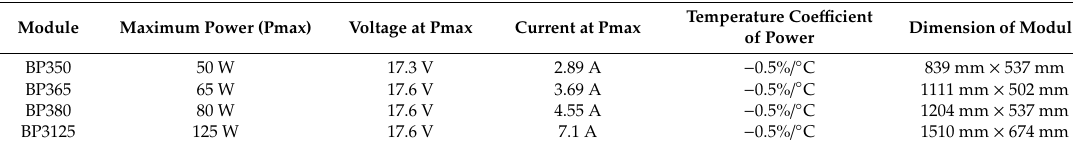
Table 1. Characteristics of BP3 series solar panel